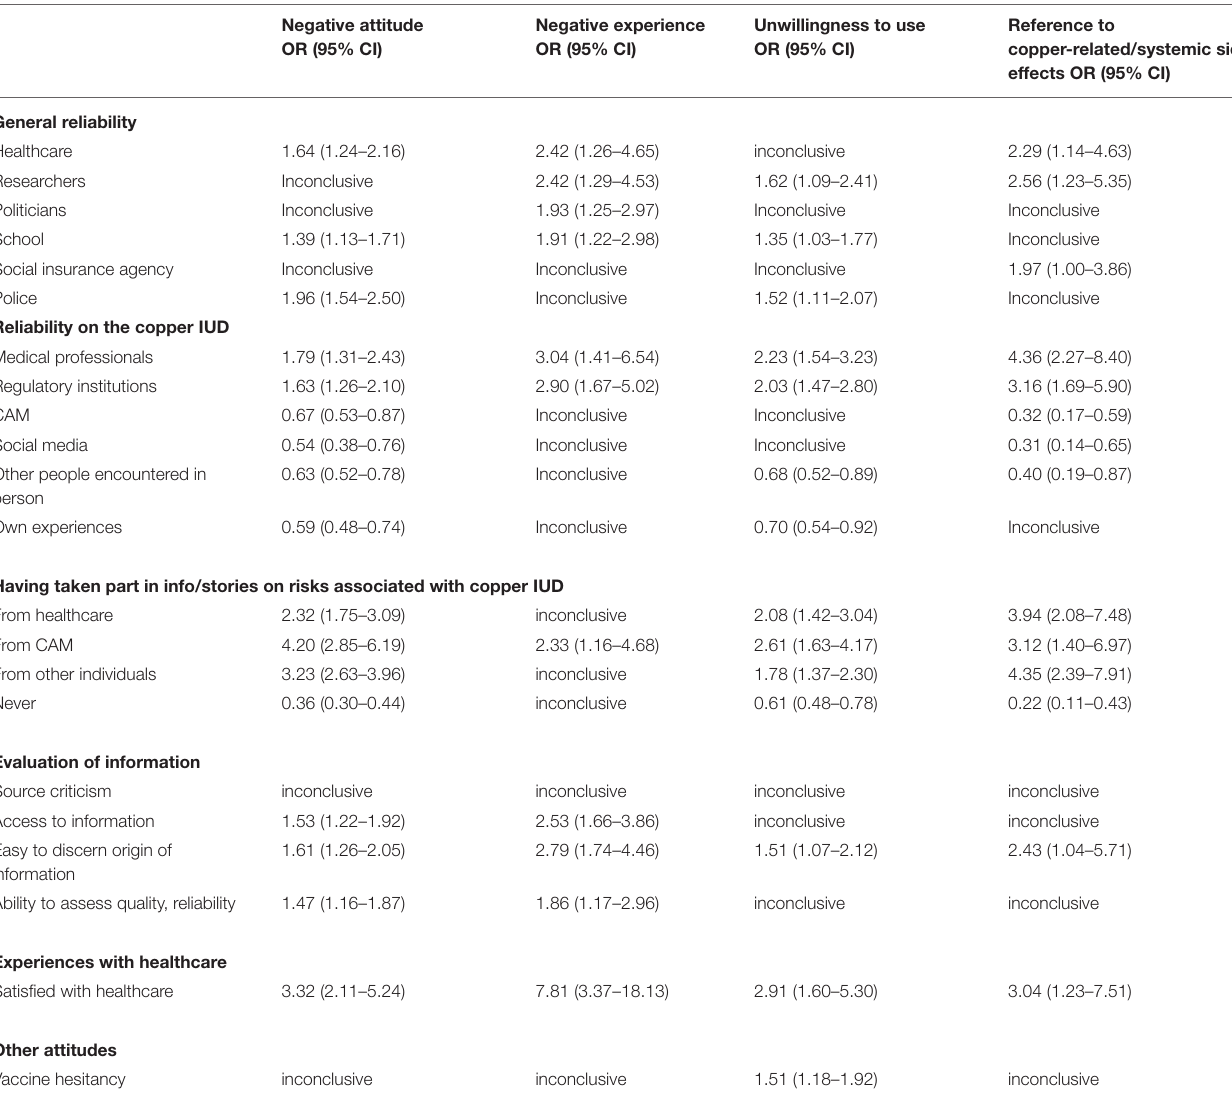
TABLE 5 | Associations between attitudes regarding information and healthcare and negative attitudes toward IUD, expressed as odds ratios (ORs) with 95% confidence intervals